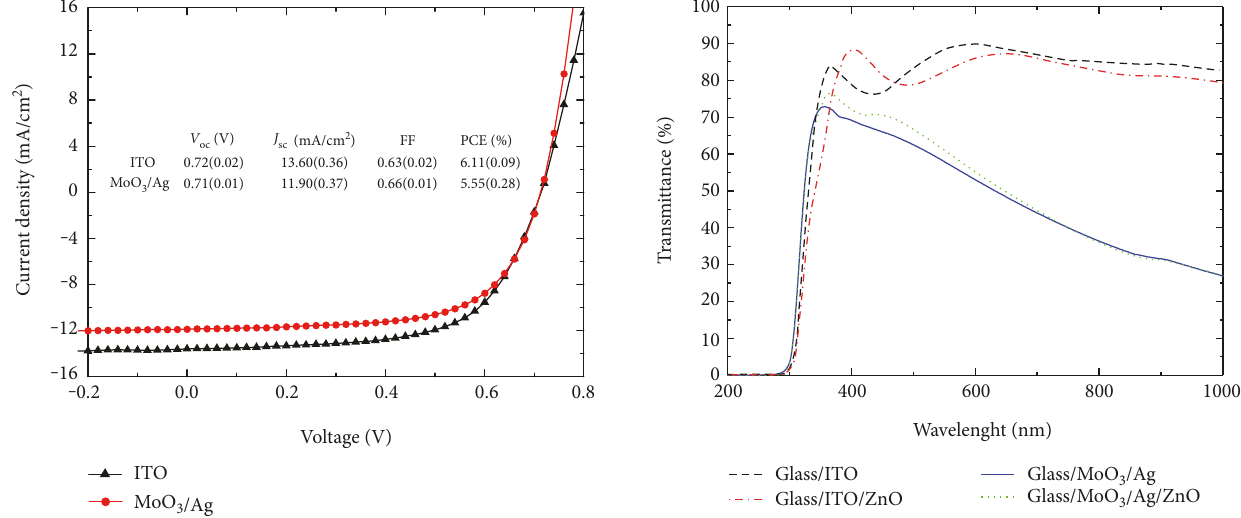
Figure 2: J - V characteristics for inverted ITO-free OSCs based on MoO /Ag electrode and ITO-based reference OSCs. The 3 corresponding photovoltaic parameters have also been shown here as an inset for comparison.